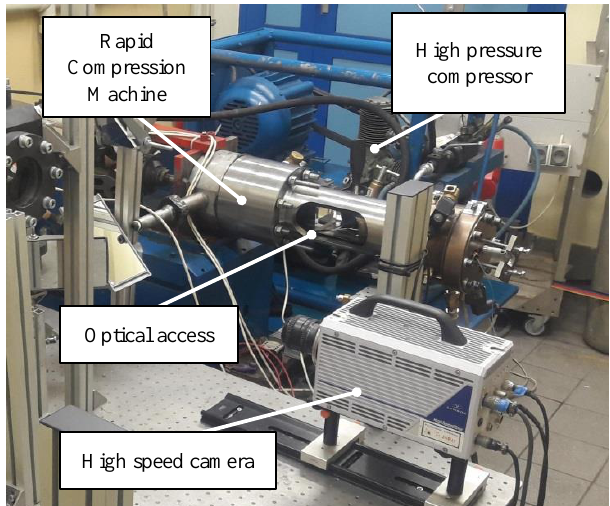
Fig. 3. Test stand for optical research on RCM